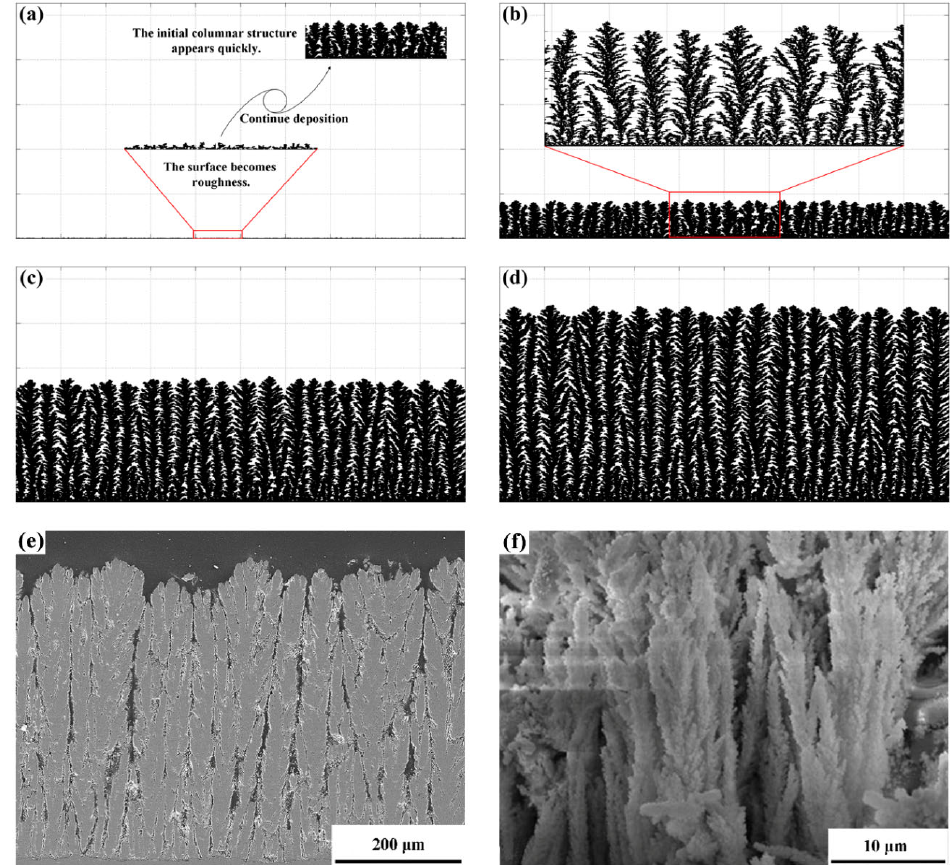
Fig. 77 Structure development of coating: (a) rapid formation of rough fluctuations, (b) formation of initial columnar structures, (c) coating growth, (d) final coating with feather-like columnar structures, (e) polished section of coating, and (f) cross-section morphology of fractured coating. Reproduced with permission from Ref. [414], © Published by Elsevier B.V.